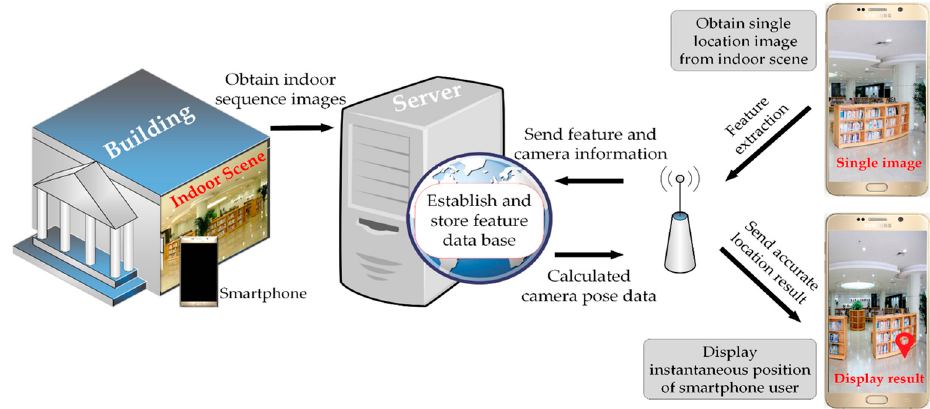
Figure 1. The workflow chart of the indoor visual positioning system proposed in this paper.